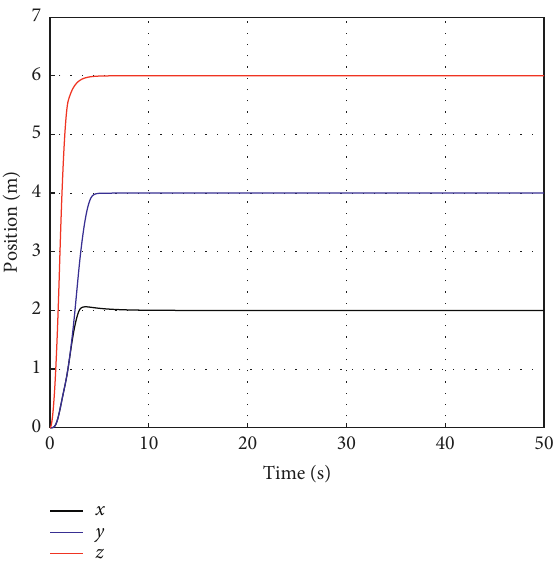
Figure 4: Curve of position